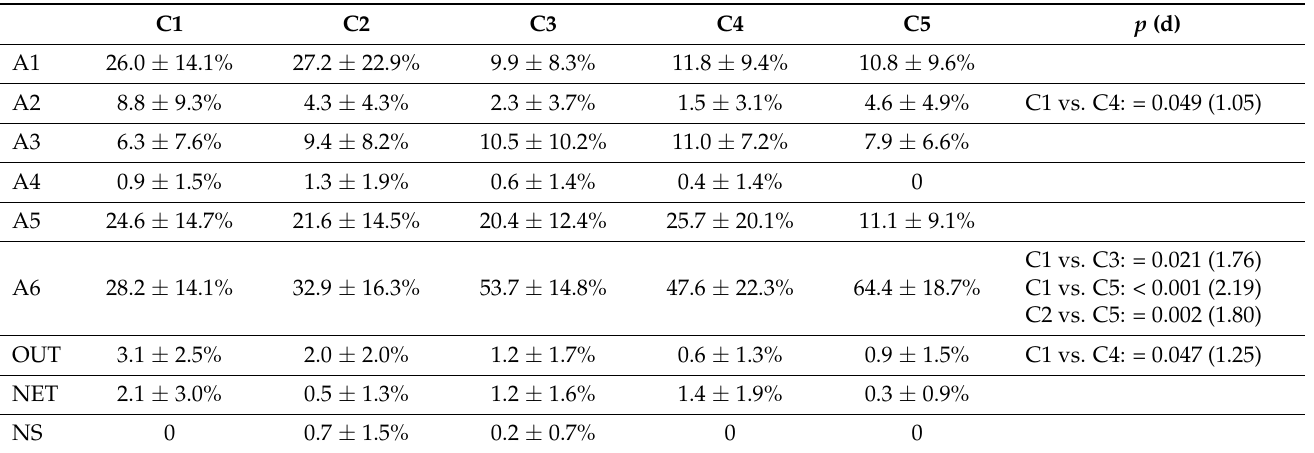
Table 7. Distribution of area of ball bouncing after serve for each class (mean ± SD).